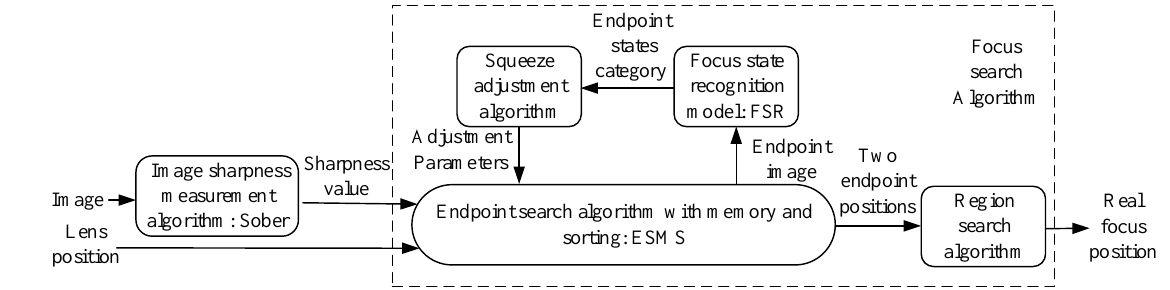
Figure 2. Overview of designed auto-focus